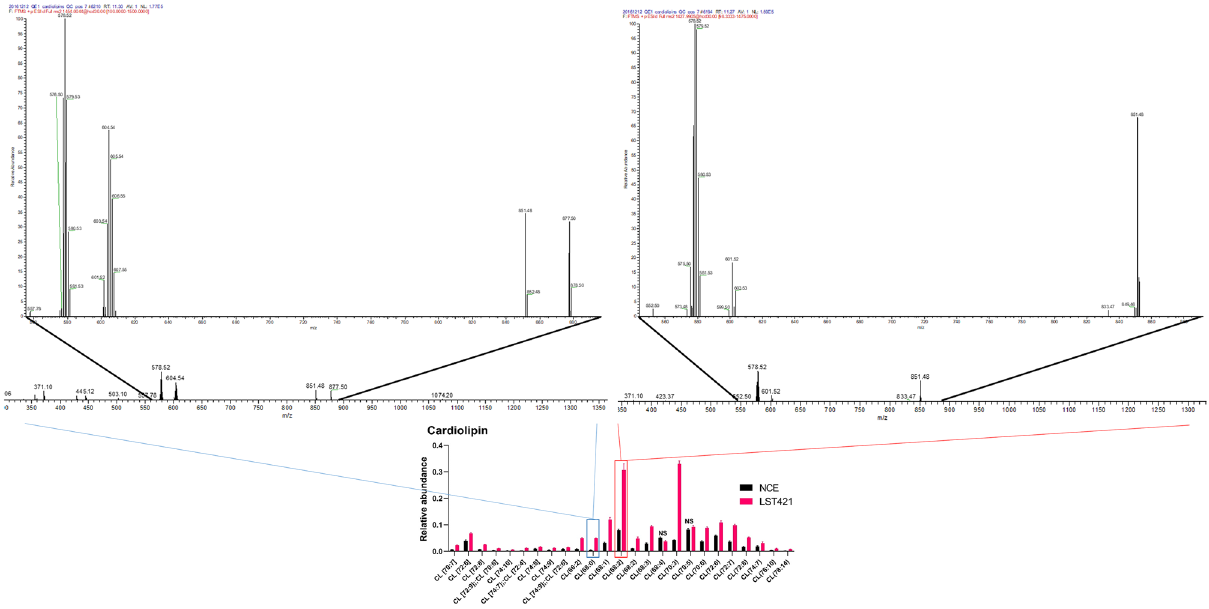
Figure 5. Top right; HCD MS/MS mass spectrum for a cardiolipin (CL[68:2]) detected at a mass-to-charge ratio (m/z) of 1427.9905 for the product ion demonstrating the characteristic precursor and product ions. The x-axis represents the m/z and the y-axis represents response. The figure visualises the full MS/MS spectrum (large plot) with the m/z region where product ions are detected being increased in size in the smaller insert. Top left: HCD MS/MS mass spectrum for a cardiolipin (CL[68:0]) detected at a mass-to-charge ratio (m/z) of 1454.0044 for the product ion demonstrating the characteristic precursor and product ions. The x-axis represents the m/z and the y-axis represents response. Bottom; Relative changes in the abundance of cardiolipin metabolites in NCE and cytoglobin expressing cells. All grouped columns represent significant changes between both conditions except where NS (not significant) is